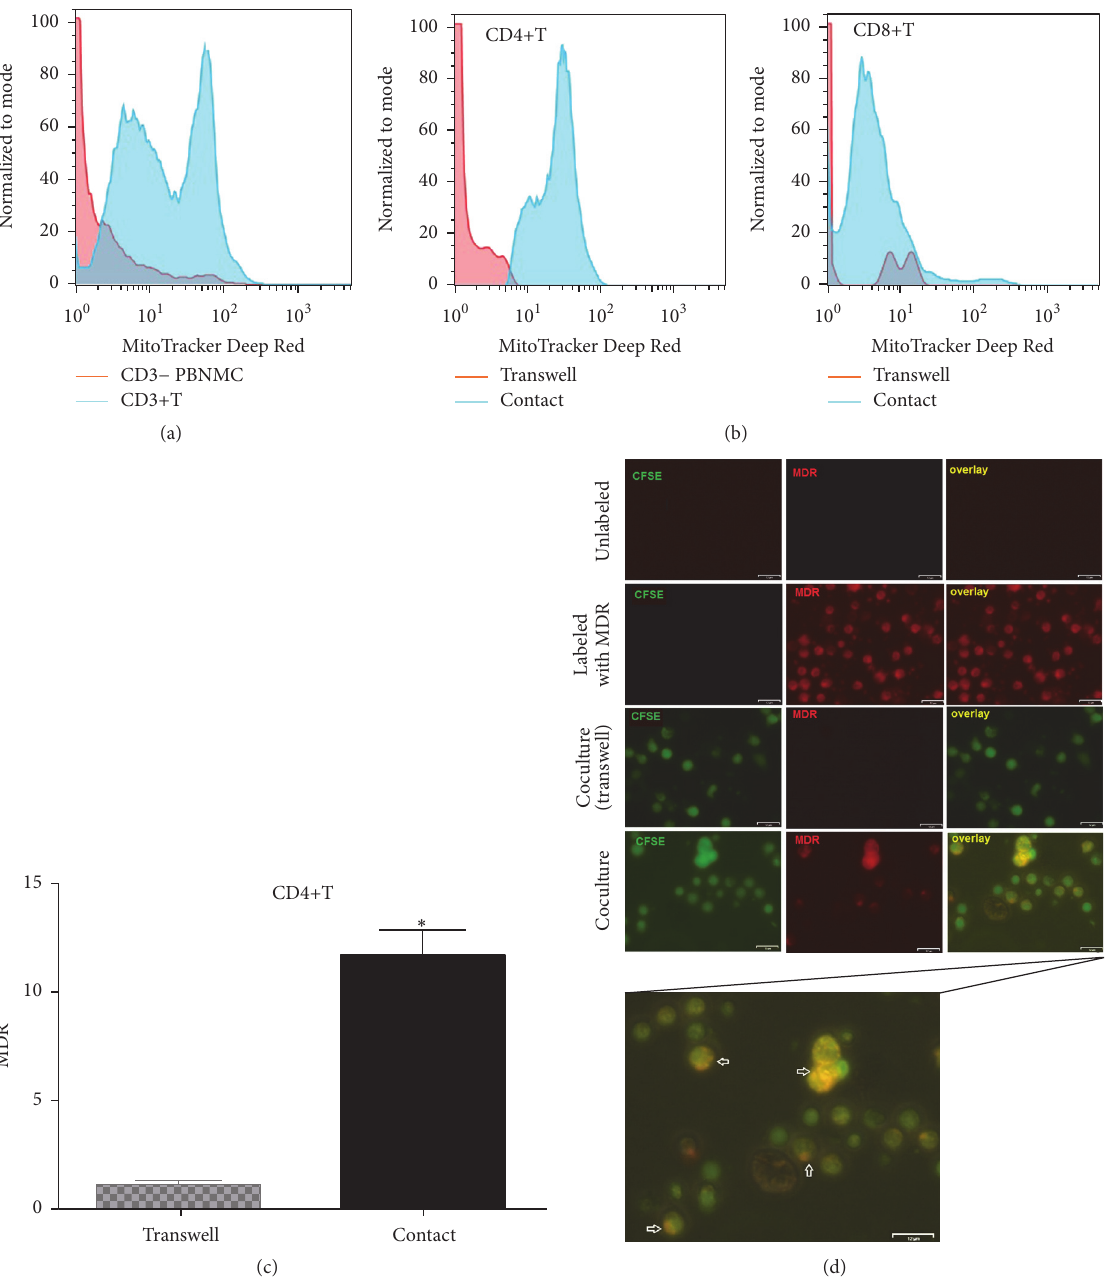
Figure 7: UC-MSCs transferred mitochondria to activate T cells. PBMCs from SLE patients were labeled with carboxyfluorescein succinimidyl amino ester (CFSE) and treated with anti-CD3/CD28 antibodies for two days. Then they were cocultured with UC-MSCs for 12h,whichhadbeenprelabeledwithrespiratorymitochondrionspecificprobeMitotrackerDeepRed(MDR).PBMCswereculturedwithUC- MSCs through transwell as control. Then PBMCs were stained with anti-CD3, anti-CD4, or anti-CD8 dye and detected for MDR fluorescence with flow cytometry. Fluorescence microscopy was carried out similarly with anti-CD3/28 stimulation for 12h and then cocultured for 6 h. All experiments were performed in triplicate. (a) T cells (CD3 positive) rather than non-T cells (CD3 negative) got MDR staining. (b–d) T cells cultured with UC-MSCs directly rather than through transwell got transferred mitochondria ( 𝑛 = 3 ). Arrows indicated transferred mitochondria within lymphocytes. ∗ 𝑝 < 0.05